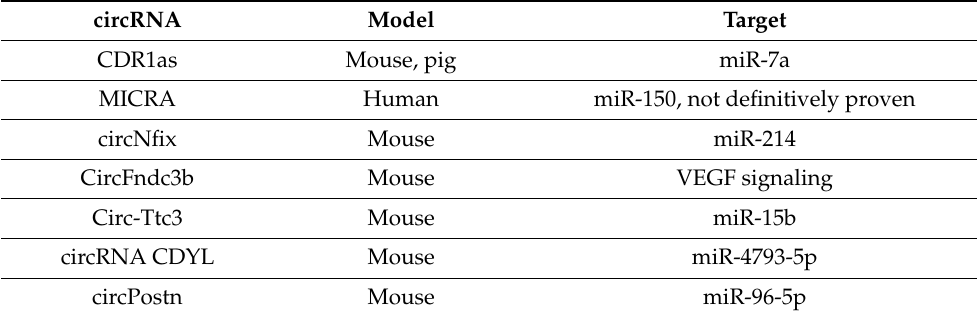
Table 1. circRNAs mentioned in this review. Abbreviations: circRNA; MICRA—myocardial infarction-associated circular RNA; VEGF—vascular endothelial growth